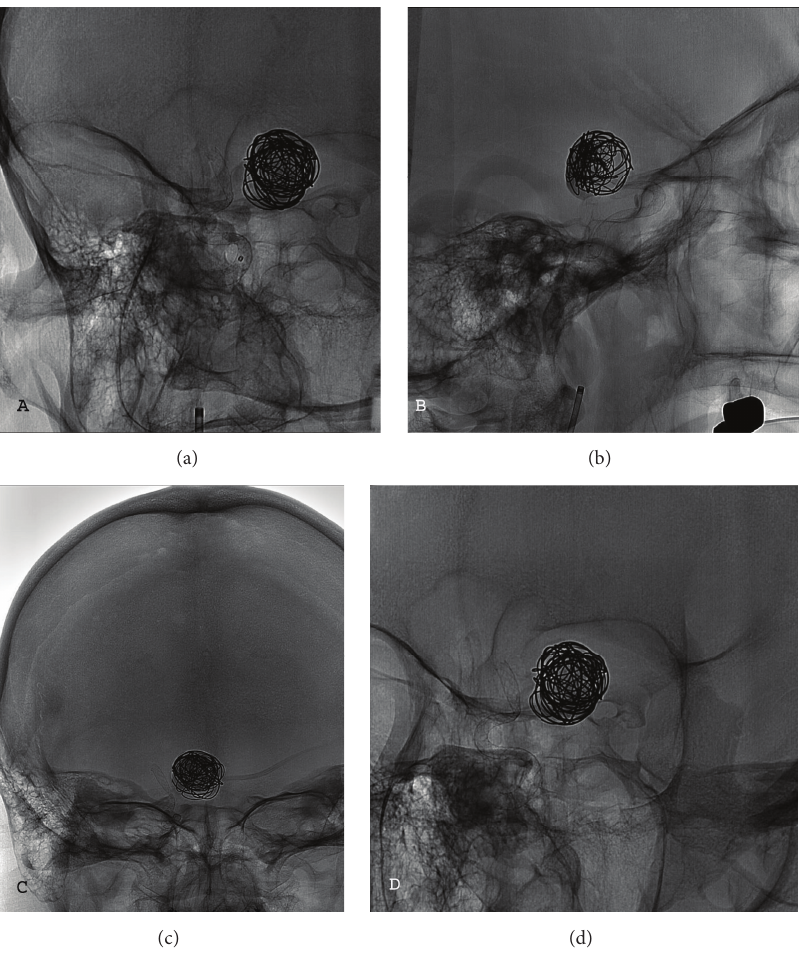
Figure 2: (a to d) The images show the FD in different